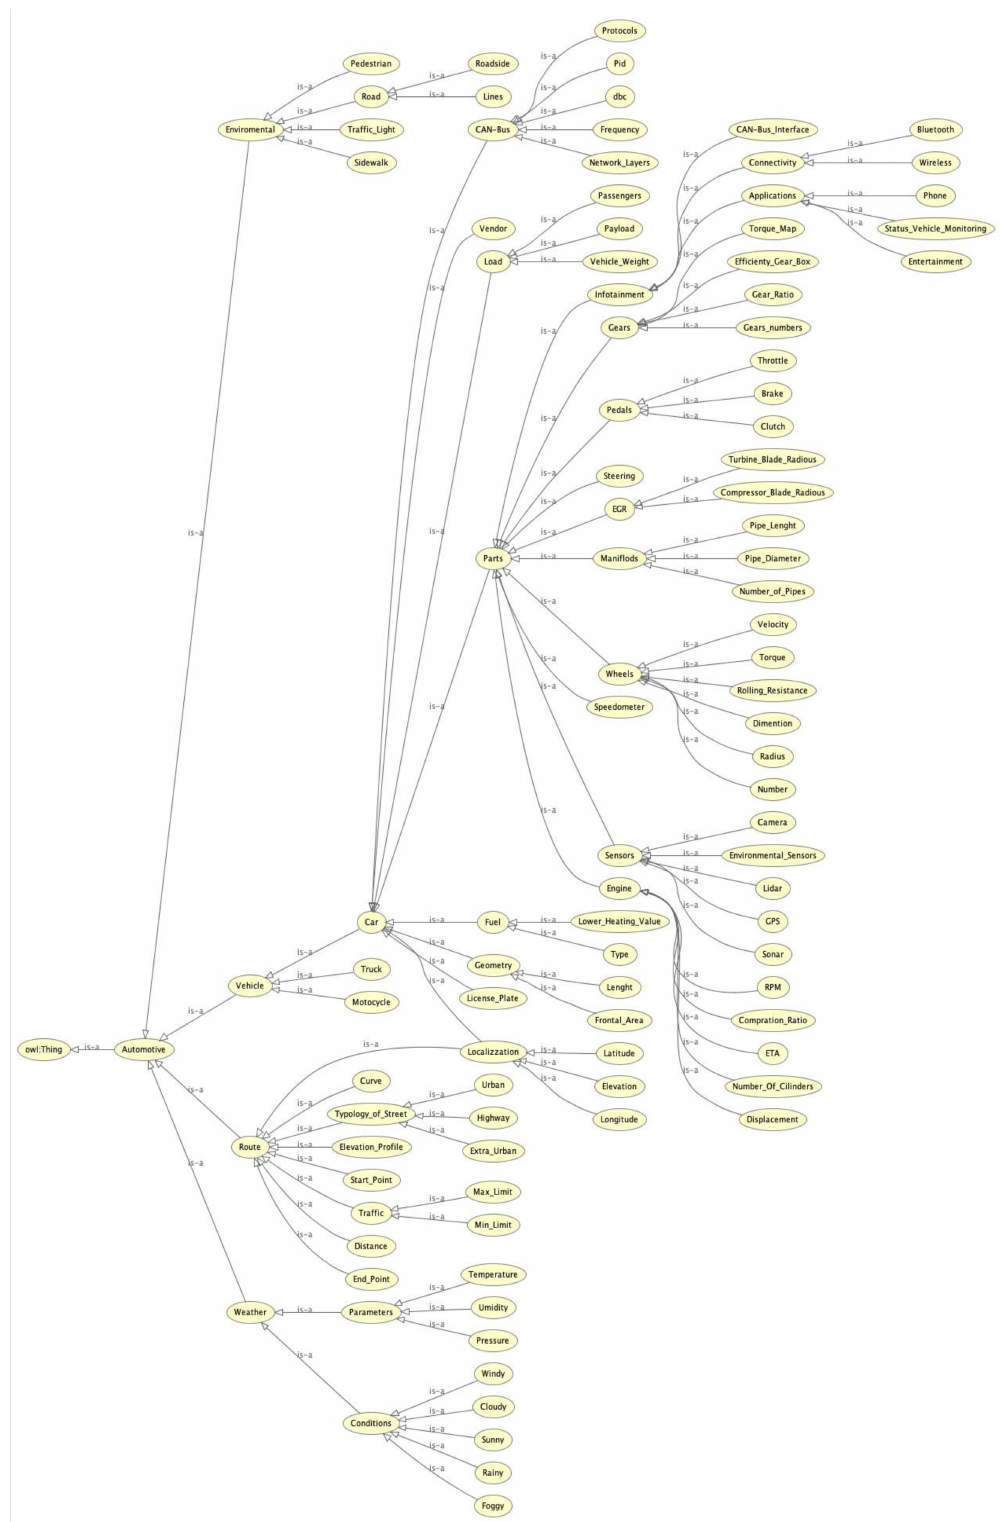
Figure 1. Obtained taxonomy from domain